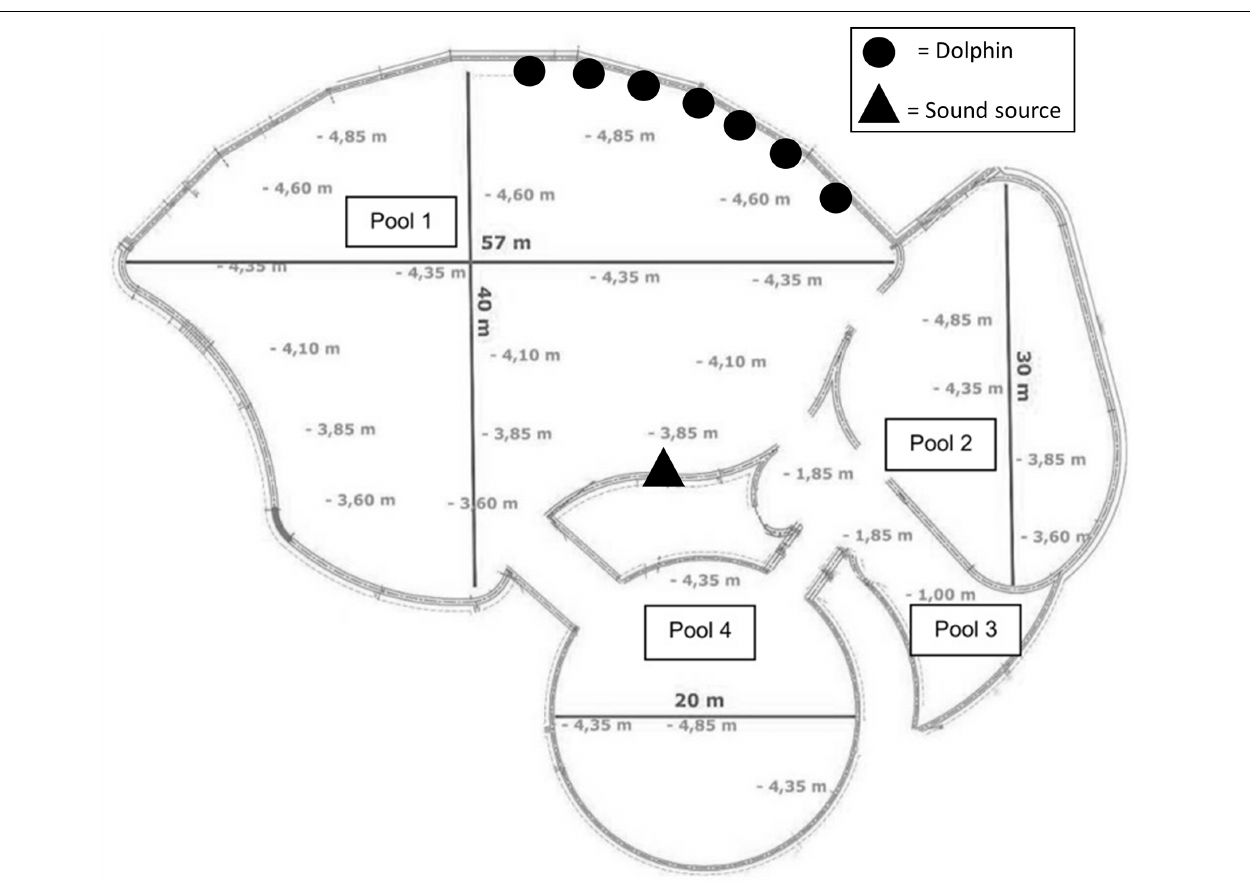
FIGURE 1 | Schematic representation of the four pools at Planète Sauvage (adapted from Planète Sauvage ). The symbols represent the position of individuals at the beginning of each test (“Dolphin,” random order of alignment) and the trainer operating the instruments (“sound source”).